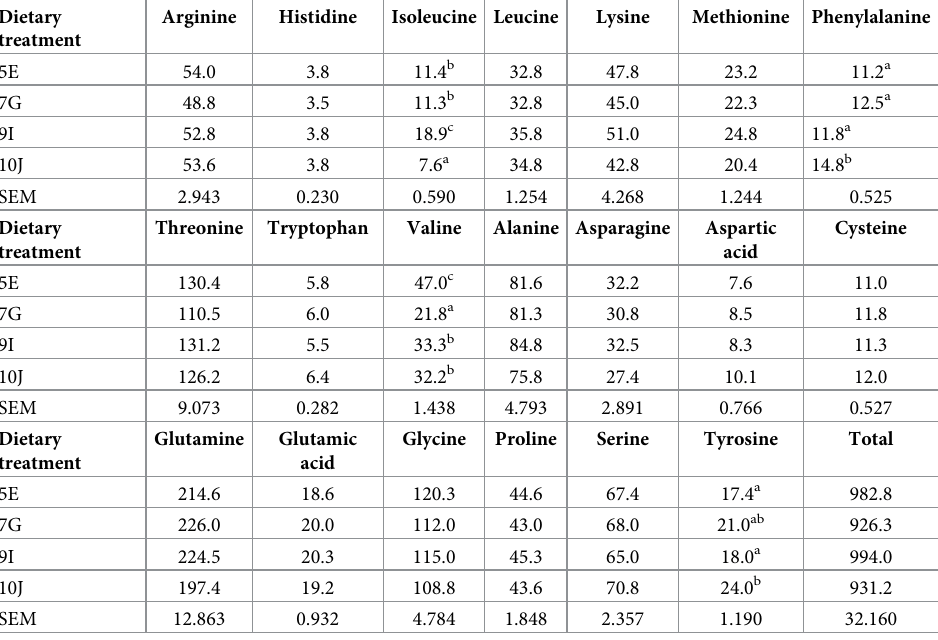
Table 15. Effects of selected dietary treatments on free amino acid systemic plasma concentrations ( μ g/mL) at 27 days post-hatch. Dietary Arginine treatment